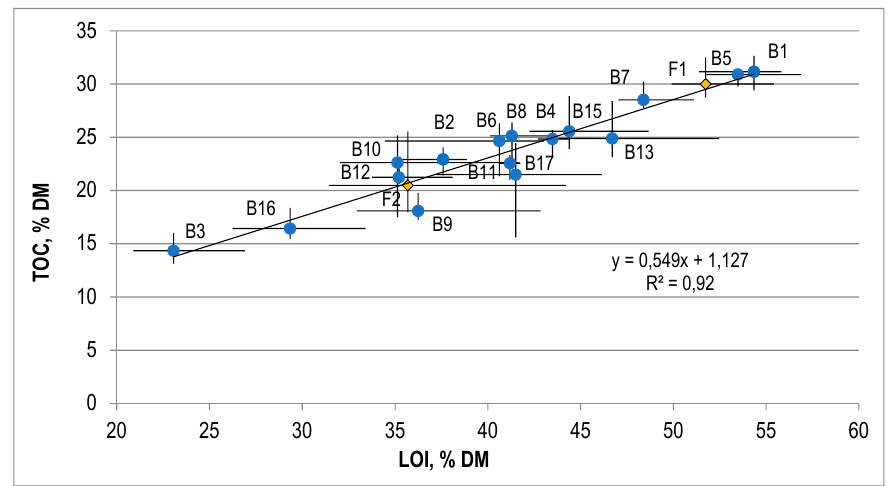
Figure 3. The correlation between the loss on ignition and the content of organic carbon in the OFMSW. Table 2. The average values of the moisture content, organic content (LOI), and total organic carbon (TOC) in the OFMSW samples directed for biological treatment in the plants that used particular waste treatment